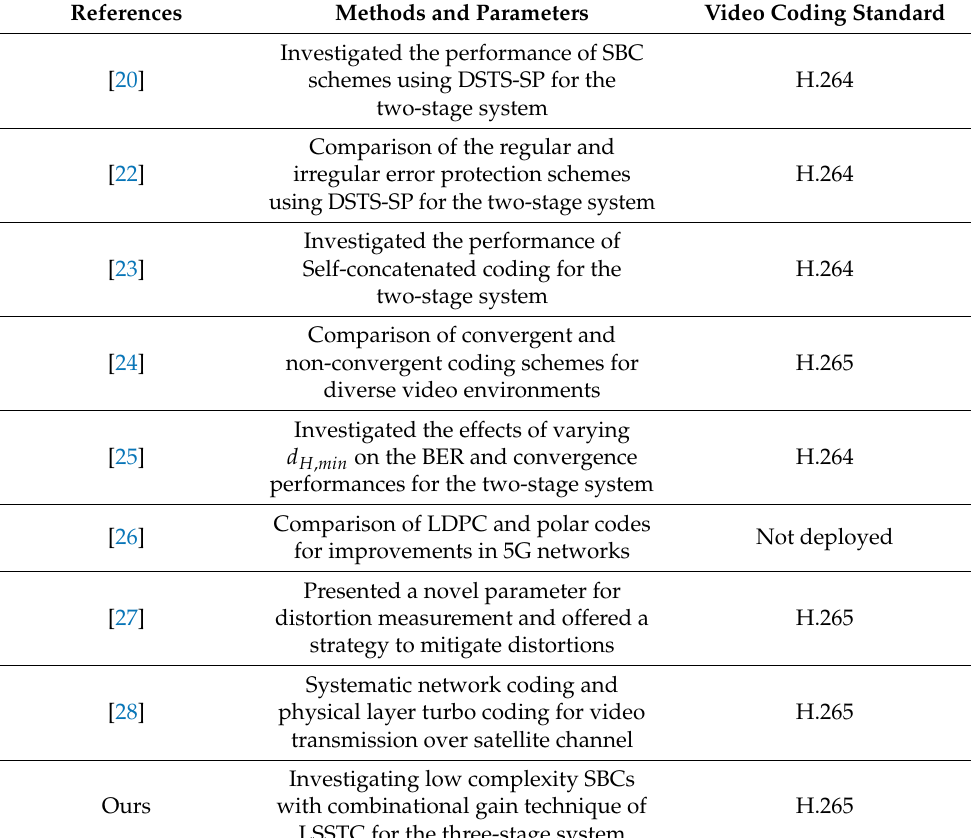
Table 1. An overview of major systems for wireless video